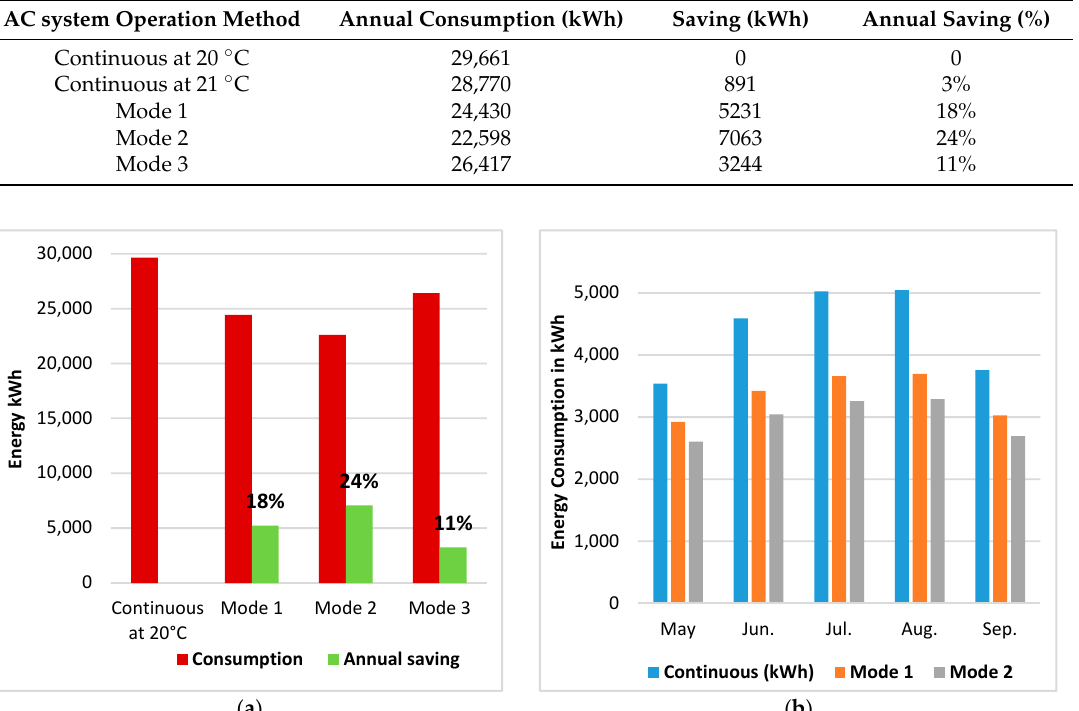
Table 4. Monthly energy consumption under the continuous and different modes of AC operation for House 1 during the summer.